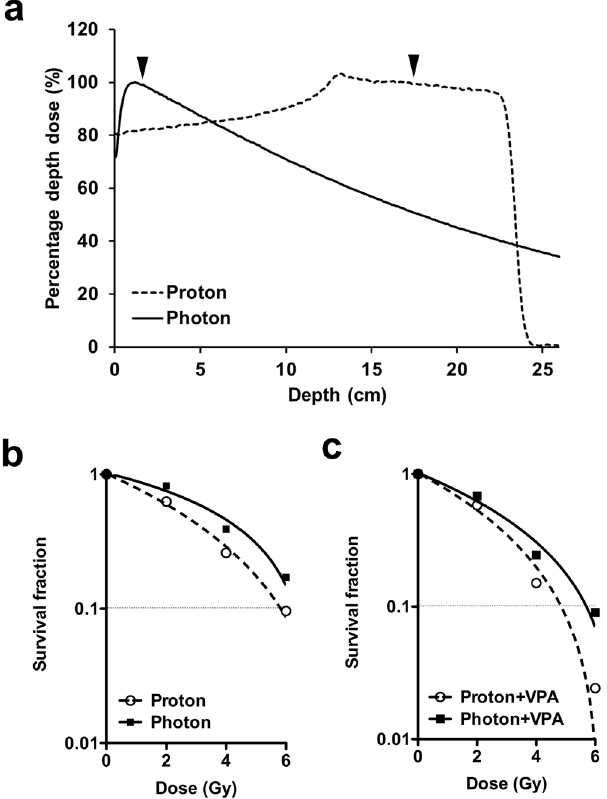
Figure 2. VPA sensitizes Hep3B cells to proton and photon irradiations. ( a ) Percentage depth dose graphs in water for photon (solid line) and proton beams (dashed line) indicate different energy distributions. Each arrowhead points to the positions at which cell plates were placed for photon or proton irradiation. ( b and c ) Clonogenic assay was performed to compare radiation sensitivity. Cells were seeded and irradiated with indicated doses of photon or proton beam with or without 1 mM VPA. After 15 days, survived colonies ( > 50 cells) were stained and counted. Representative dose-response curves are presented. Data are mean values ± SD of three samples. ( b ) Proton vs photon; ( c ) Proton + VPA vs photon +